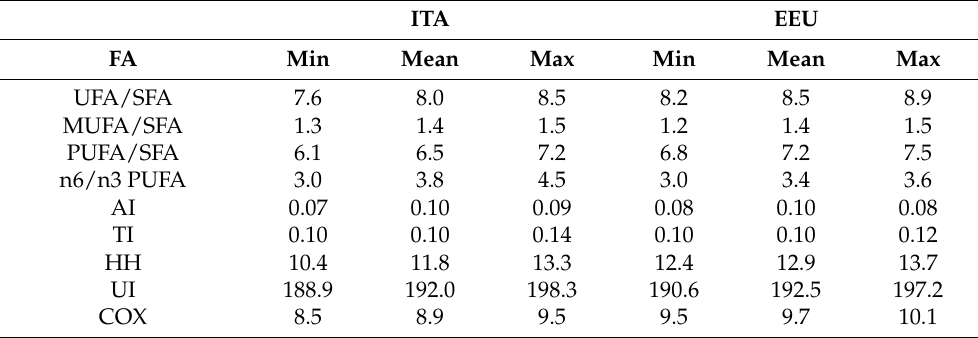
Table 2. FA ratios and nutritional quality indexes (minimum, mean, maximum values, n = 4) of HSO samples.